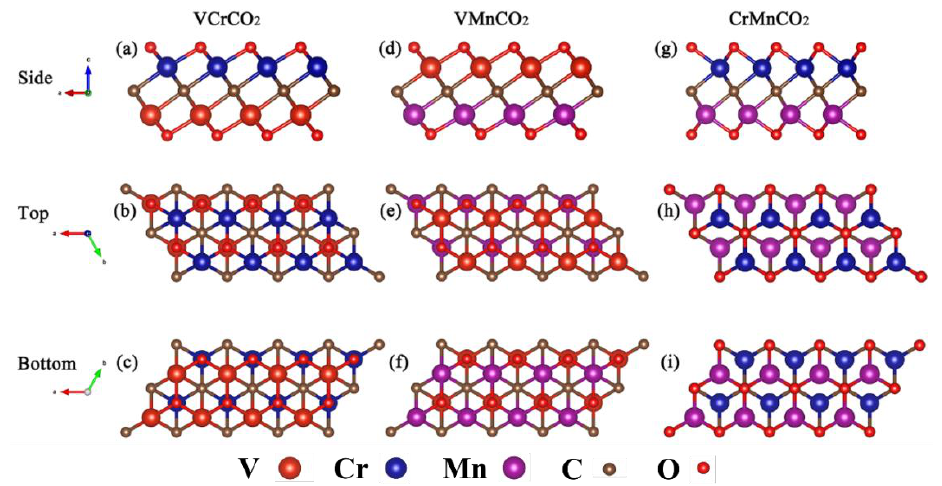
Figure 2. VCrCO 2 , VMnCO 2 , and CrMnCO 2 structures: ( a , d , g ) and ( b , e , h ) and ( c , f , i ) are the side, top, and bottom views of VCrCO 2 , VMnCO 2 , and CrMnCO 2 structures, respectively.